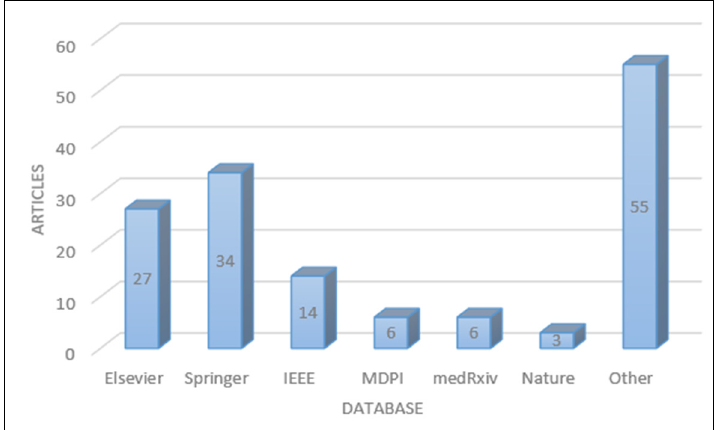
Figure 1. Number of articles per database.